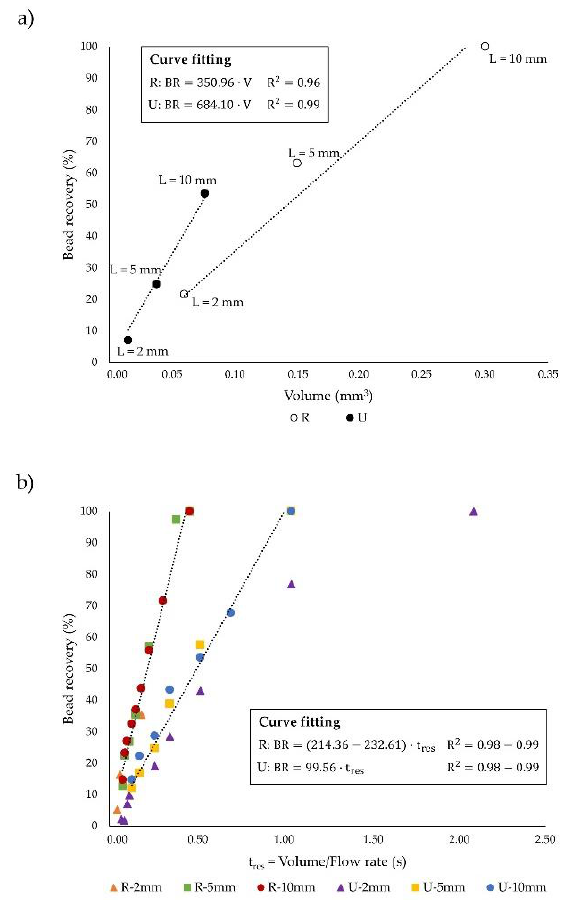
Figure 7. Dependence of bead capture on the ( a ) functional channel volume and ( b ) particle residence time (t res ). Note that in the curve fitting expressions V represents the functional channel volume and that U-2mm does not accurately fit a line.